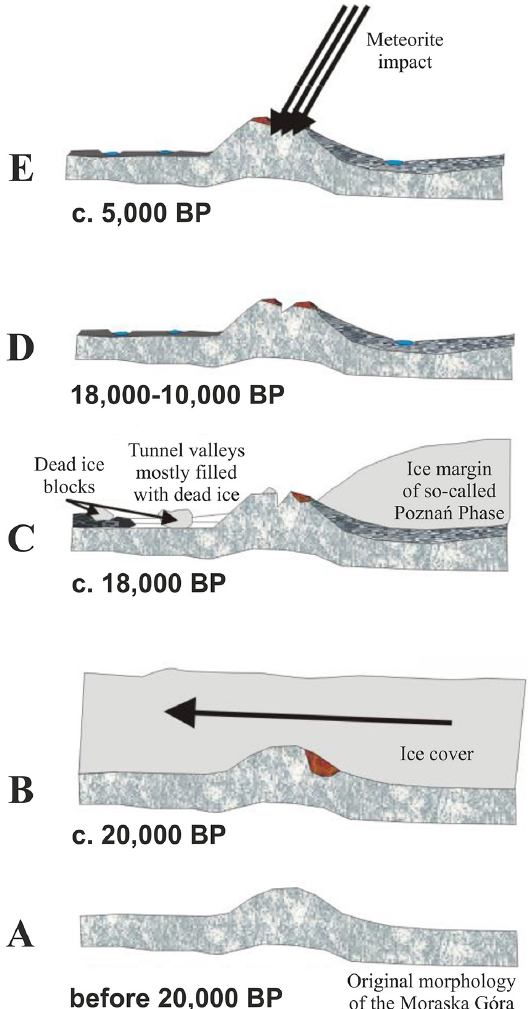
Fig. 7. Timing of main processes and morphological changes of the Morasko Hill during the Vistulian glaciation and Holocene (after Stankowski 2001 and Muszyński et al., 2014,